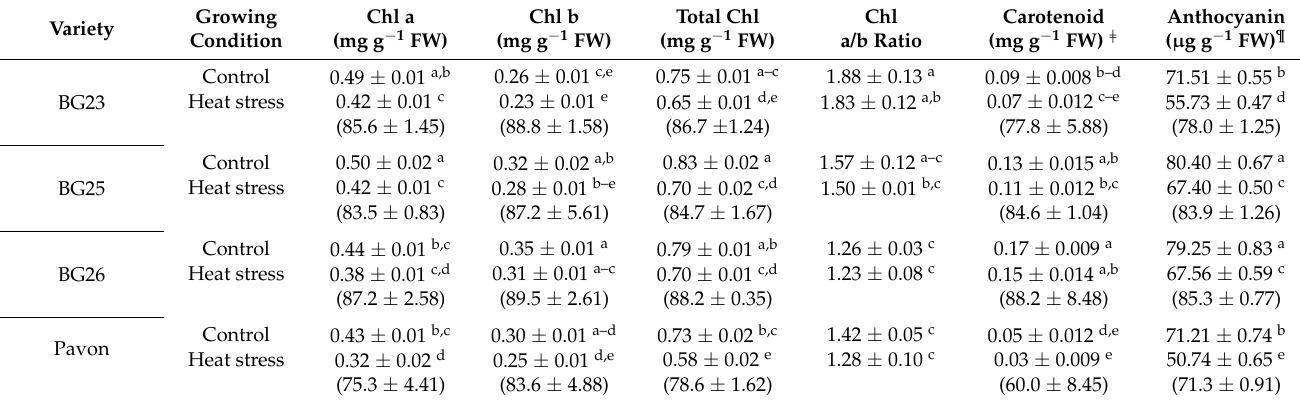
Values represent as mean ± SE. Figures in the parentheses indicate stability of that pigment. Values in a column with different letter(s) are significantly different at p ≤ 0.05. } lutein equivalent, and cyanidin-3-glucoside